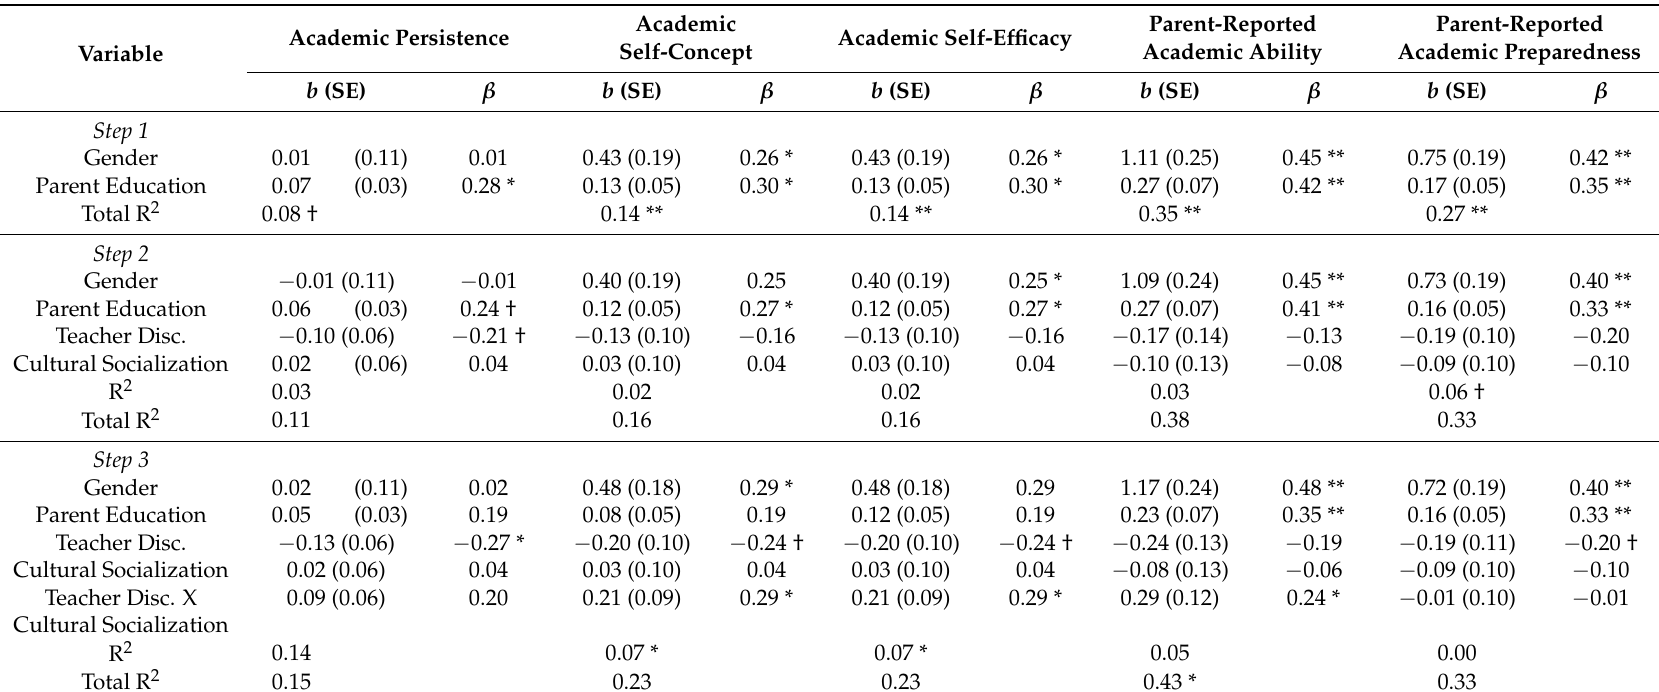
Table 5. Perceived Teacher Discrimination by Cultural Socialization: Academic